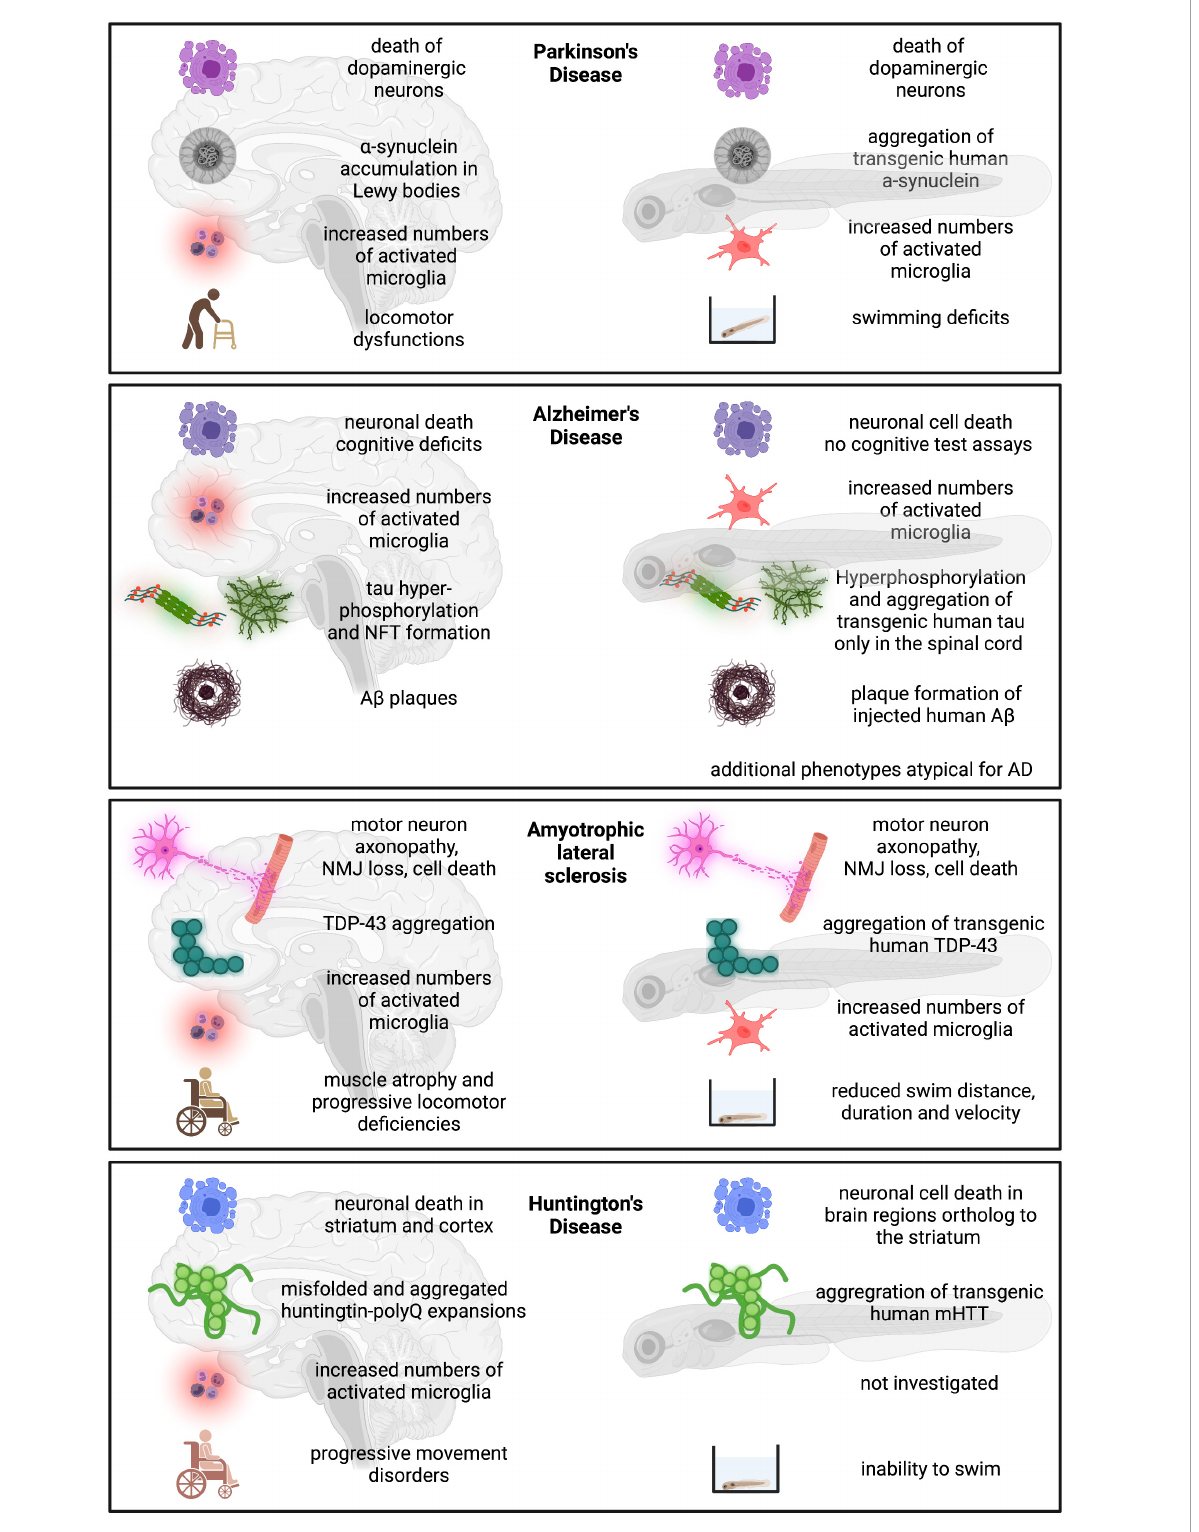
FIGURE3 Schematic overview of zebrafish model compared to human disease condition. Human disease condition on the left compared to zebrafish phenotypes on the